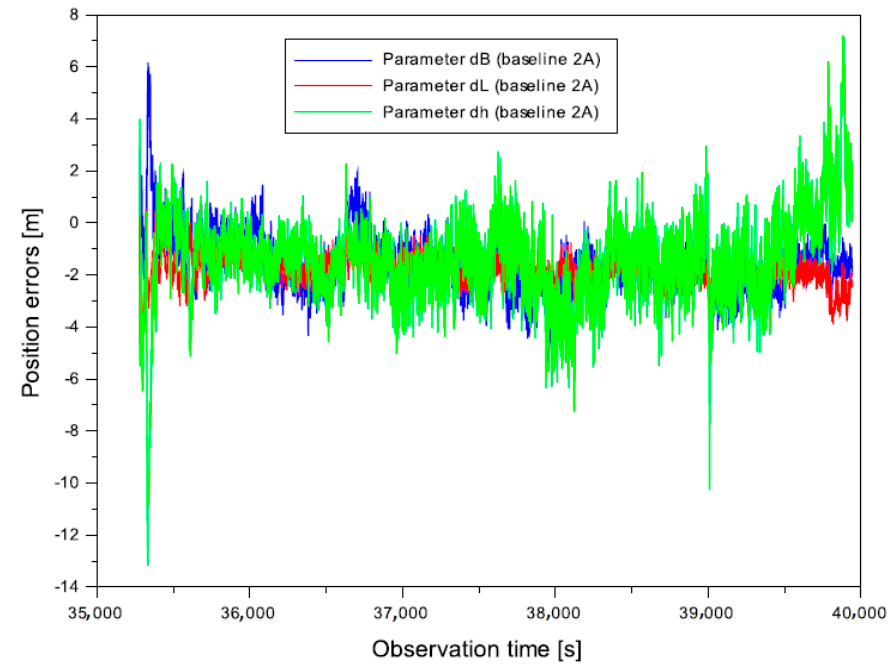
Figure 15. The results of position errors for baseline 2 A .